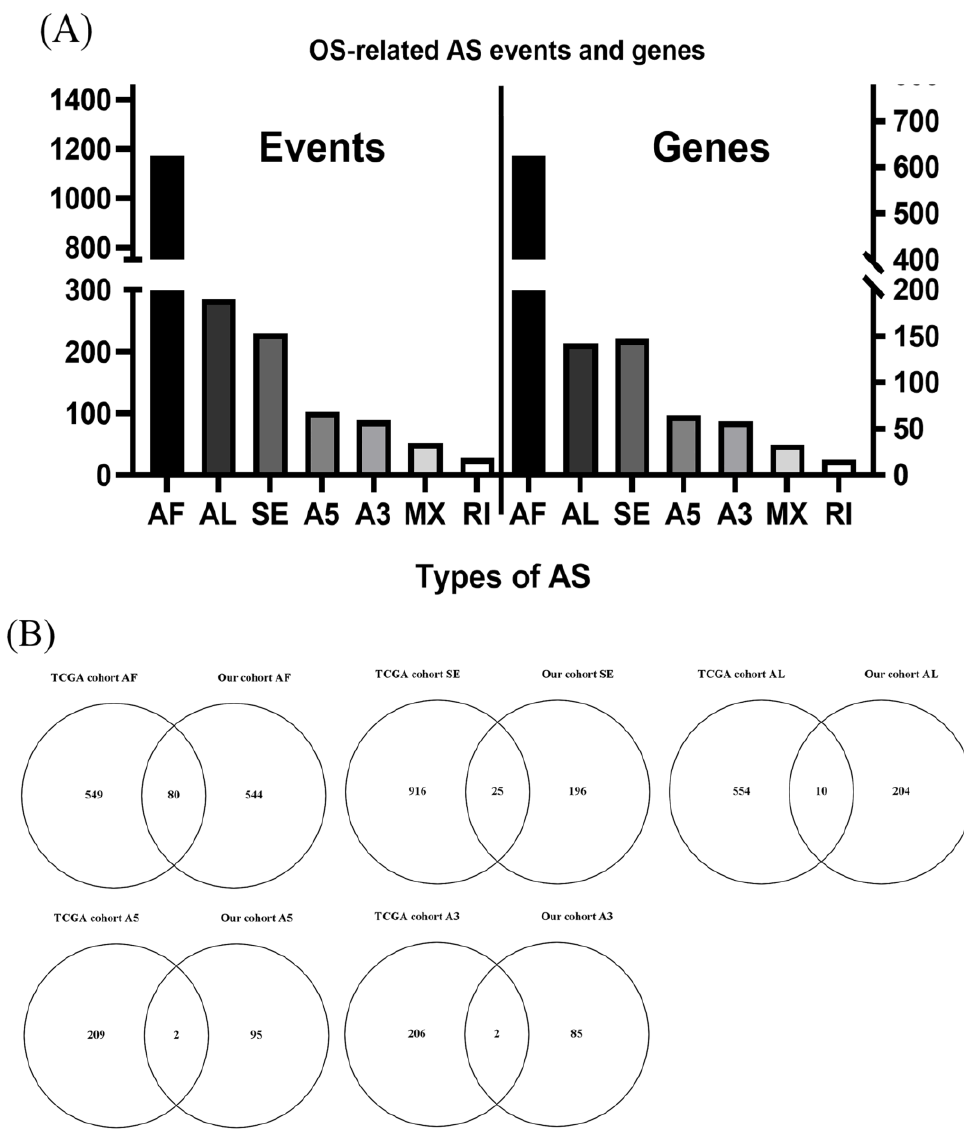
Figure 2. Overview of overall survival (OS)-related alternative splicing (AS) events. ( A ) The number of the seven types of OS-related AS events and genes involved in our lung adenocarcinoma (LUAD) cohort. ( B ) Venn diagrams showing the interrelationships between genes for LUAD in Taiwanese patients and The Cancer Genome Atlas (TCGA) databank. AF/AL: alternative first/last exons; SE: skipping exon; A5/A3: alternative5’/3’ splice site events; MX: mutually exclusive exons; RI: retained intron